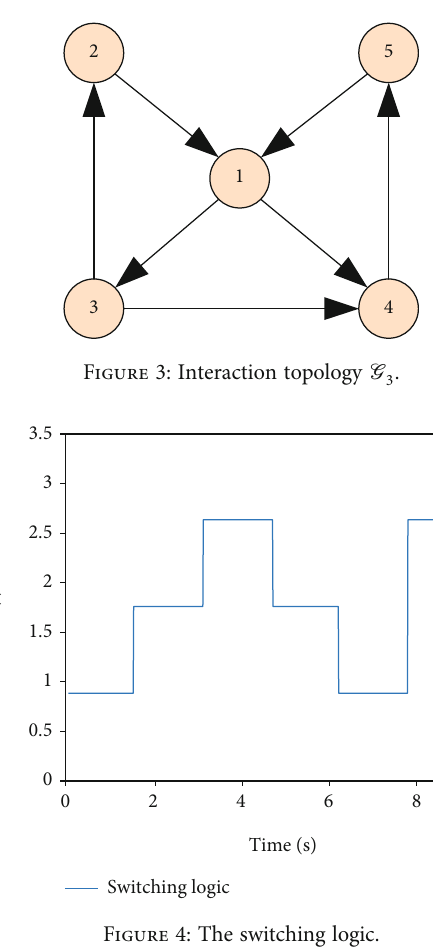
Figure 4: The switching logic.